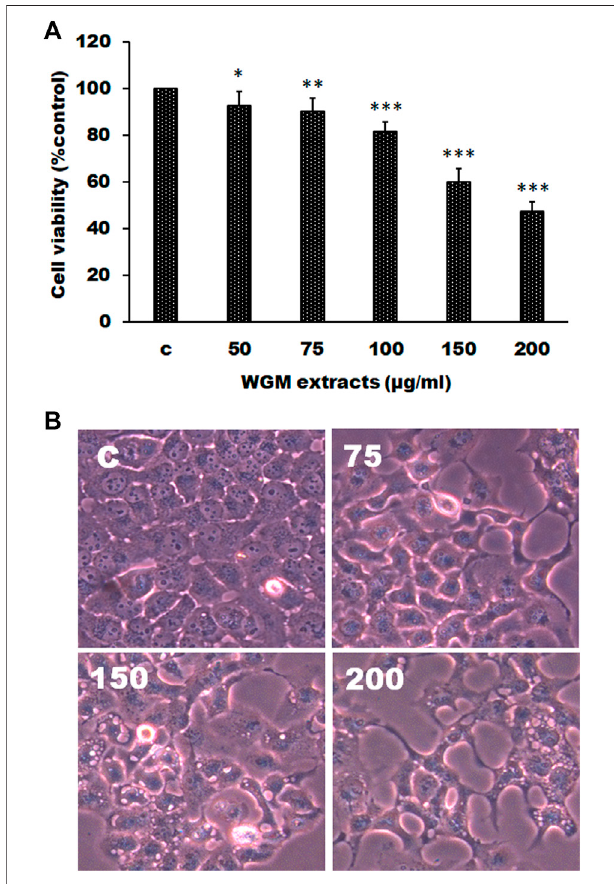
FIGURE 1 | WGM extracts induced cell death of Hep3B cells. (A) Evaluation of cytotoxicity after incubation of Hep3B cells with WGM extracts. Hep3B cells were treated with 0.1% DMSO or with 50, 75, 100, 150 or 200 μ g/ml of WGM extracts for 24 h. The cytotoxicity was evaluated by MTT assay. Data represent the mean percentage of control ±S.D. ( n = 4). * p < 0.05, ** p < 0.01, *** p < 0.001 vs. control group. (B) The effects of WGM extracts on cell morphology of Hep3B cells. Cells were incubated with 0, 75, 150 and 200 μ g/ml WGM extracts for 24 h. After WGM extracts treatment, a phase-contrast image of the cells was fast taken (150X). ( n =